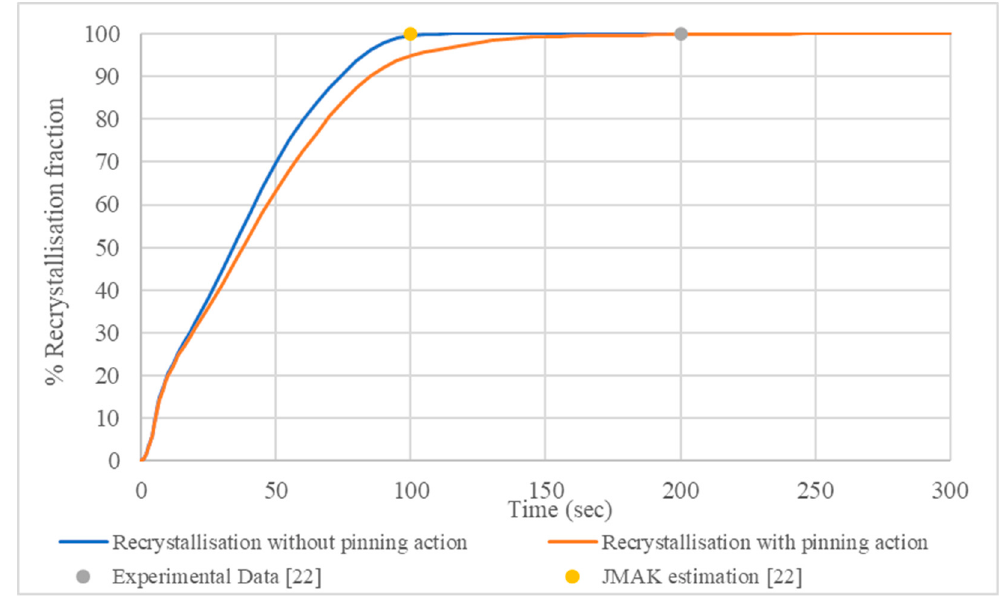
Figure 3. Evolution of recrystallisation fraction. The JMAK estimation and experimental data are taken from the work of Poletti et al. [22].